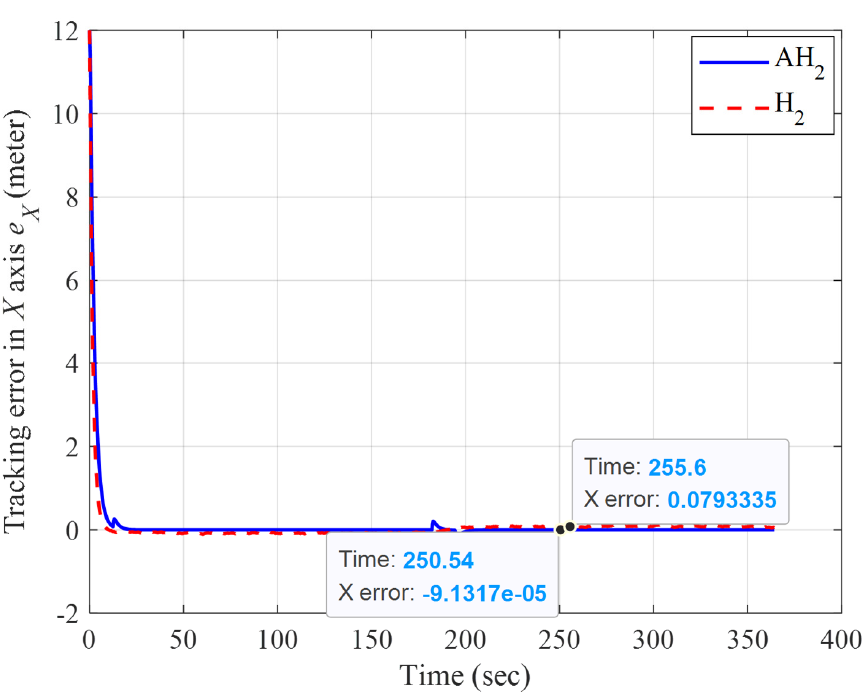
Figure 13. The square trajectory tracking error result of the adaptive H 2 closed-form and H 2 closed- form control approaches for angle from x p = − 7 m, y p = − 7 m.